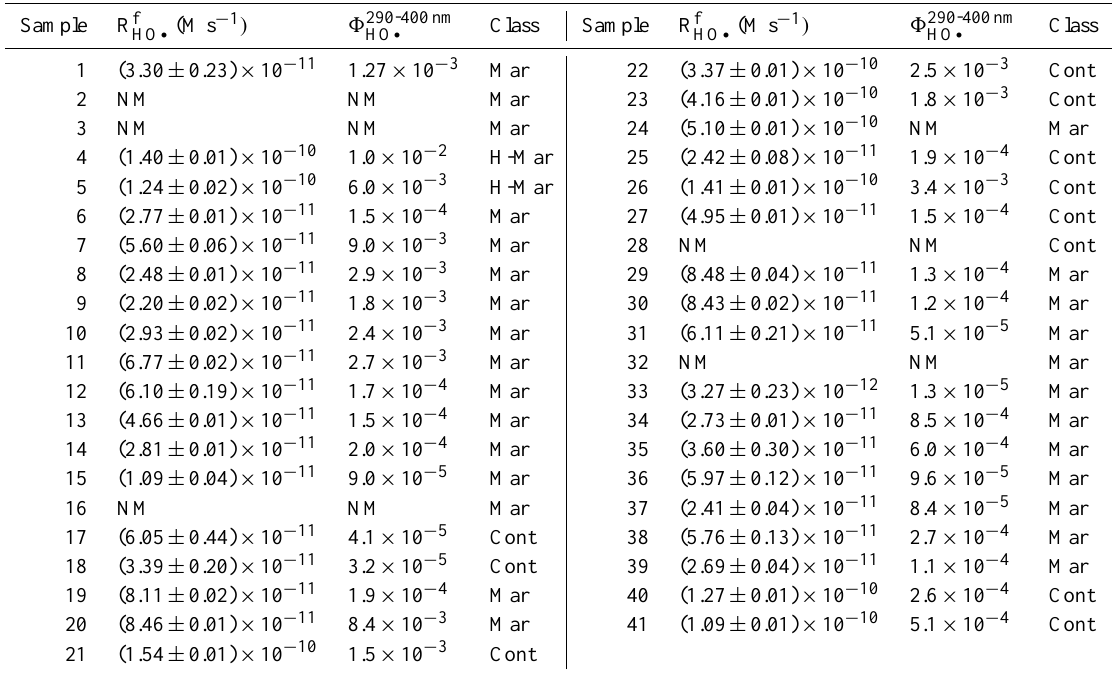
(cid:113) ) values estimated from cloud water HO (290-400nm) (cid:113) are derived at the 1 σ HO